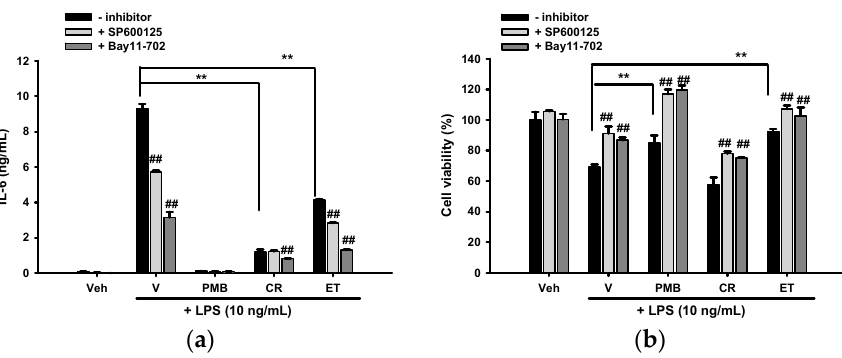
Figure 7 . Effects of signaling inhibitors on the anti-IL-6 effects of CR and ET. ( a ) BV2 cells were pretreated for 30 min with inhibitor (SP600125, 10 µM; Bay 11-7082, 10 µM) followed by CR or ET (0.1 mg/mL) for 30 min before LPS (10 ng/mL) insult for 16 h. ( a ) Supernatant was recovered for IL-6 analysis; ( b ) Cell viability was analyzed by MTT assay. Data are represented as the mean ± SD ( n = 3). Statistical differences are presented ** p < 0.01 compared with the LPS-treated vehicle and ## p < 0.01 compared with relative no inhibitor group.